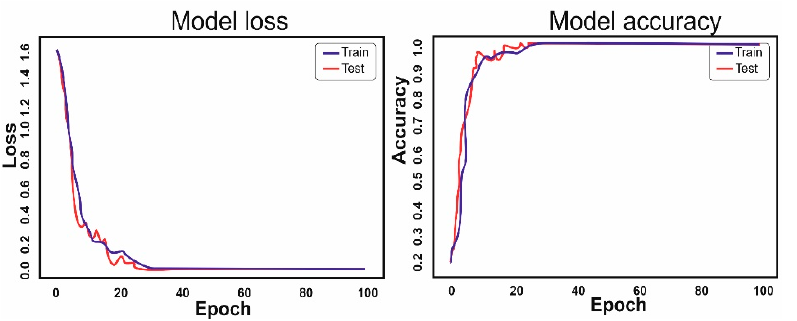
Figure 8. Graphs of the loss function and accuracy of boxers with more than 5 years of training experience.